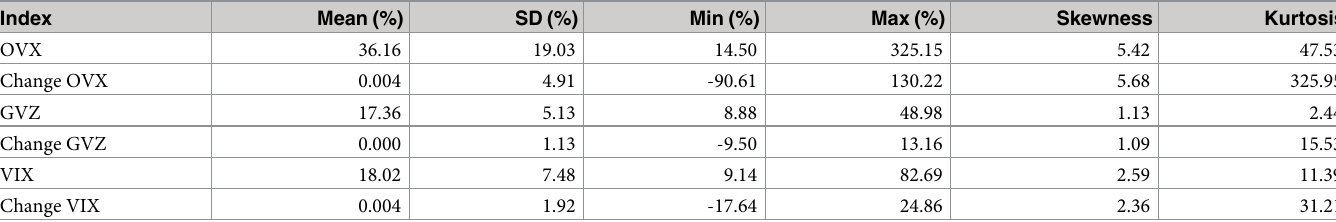
Table 1. Summary statistics full